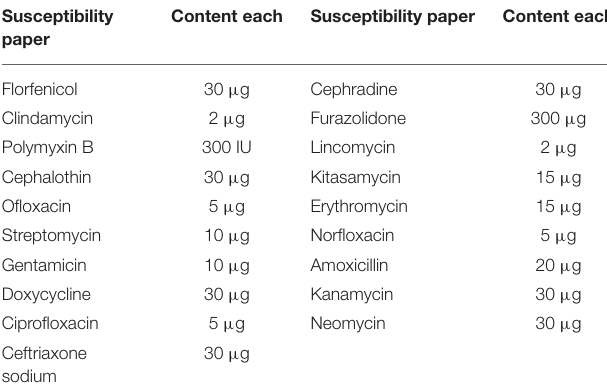
TABLE 1 | Antimicrobial sensitive paper name and